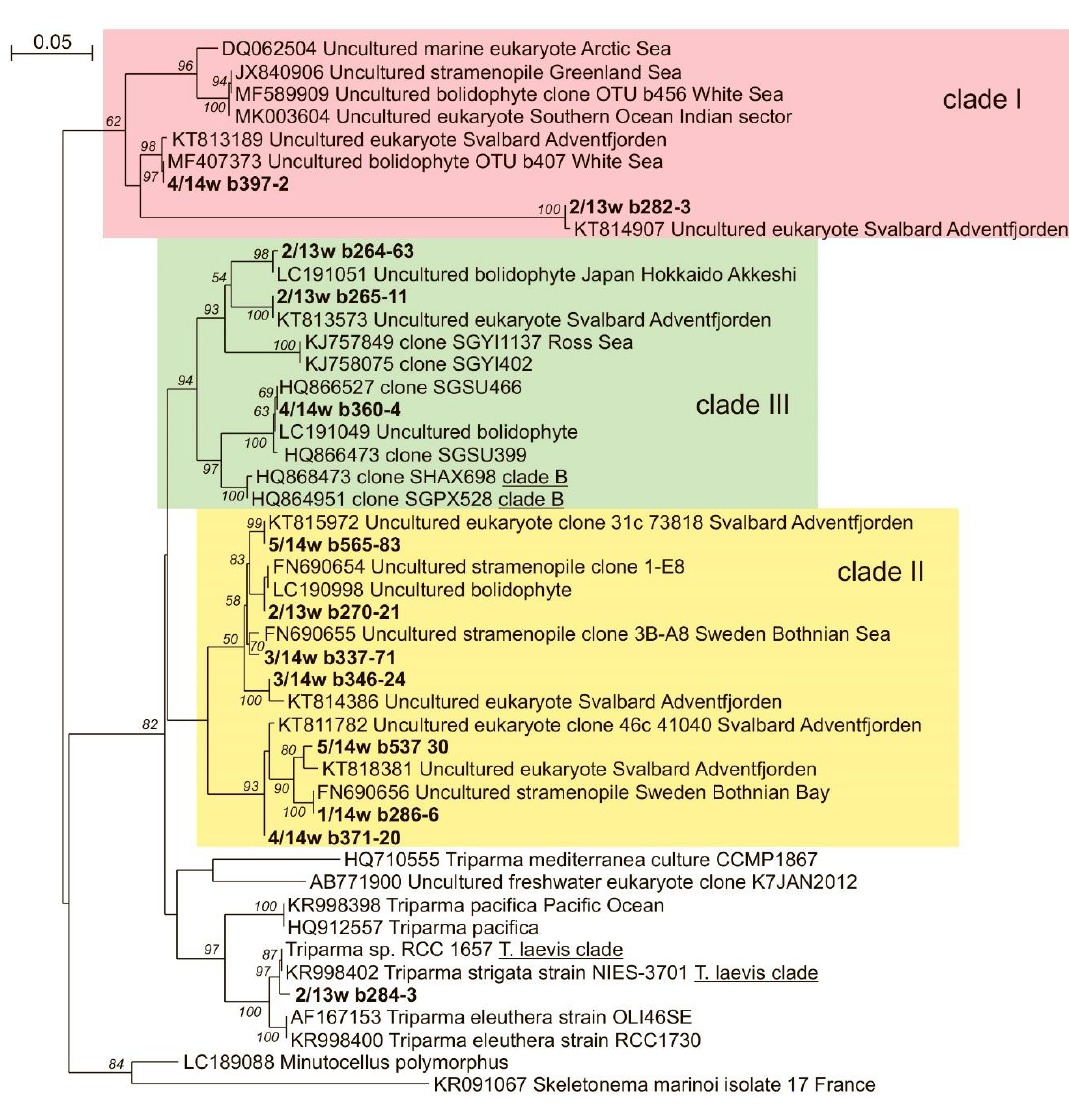
Figure 5. The maximum likelihood Bolidophyceae phylogenetic tree constructed from the V4 region of the 18S rDNA. Bootstrap support values > 50% are indicated. The scale is the number of nucleotide substitutions per site.